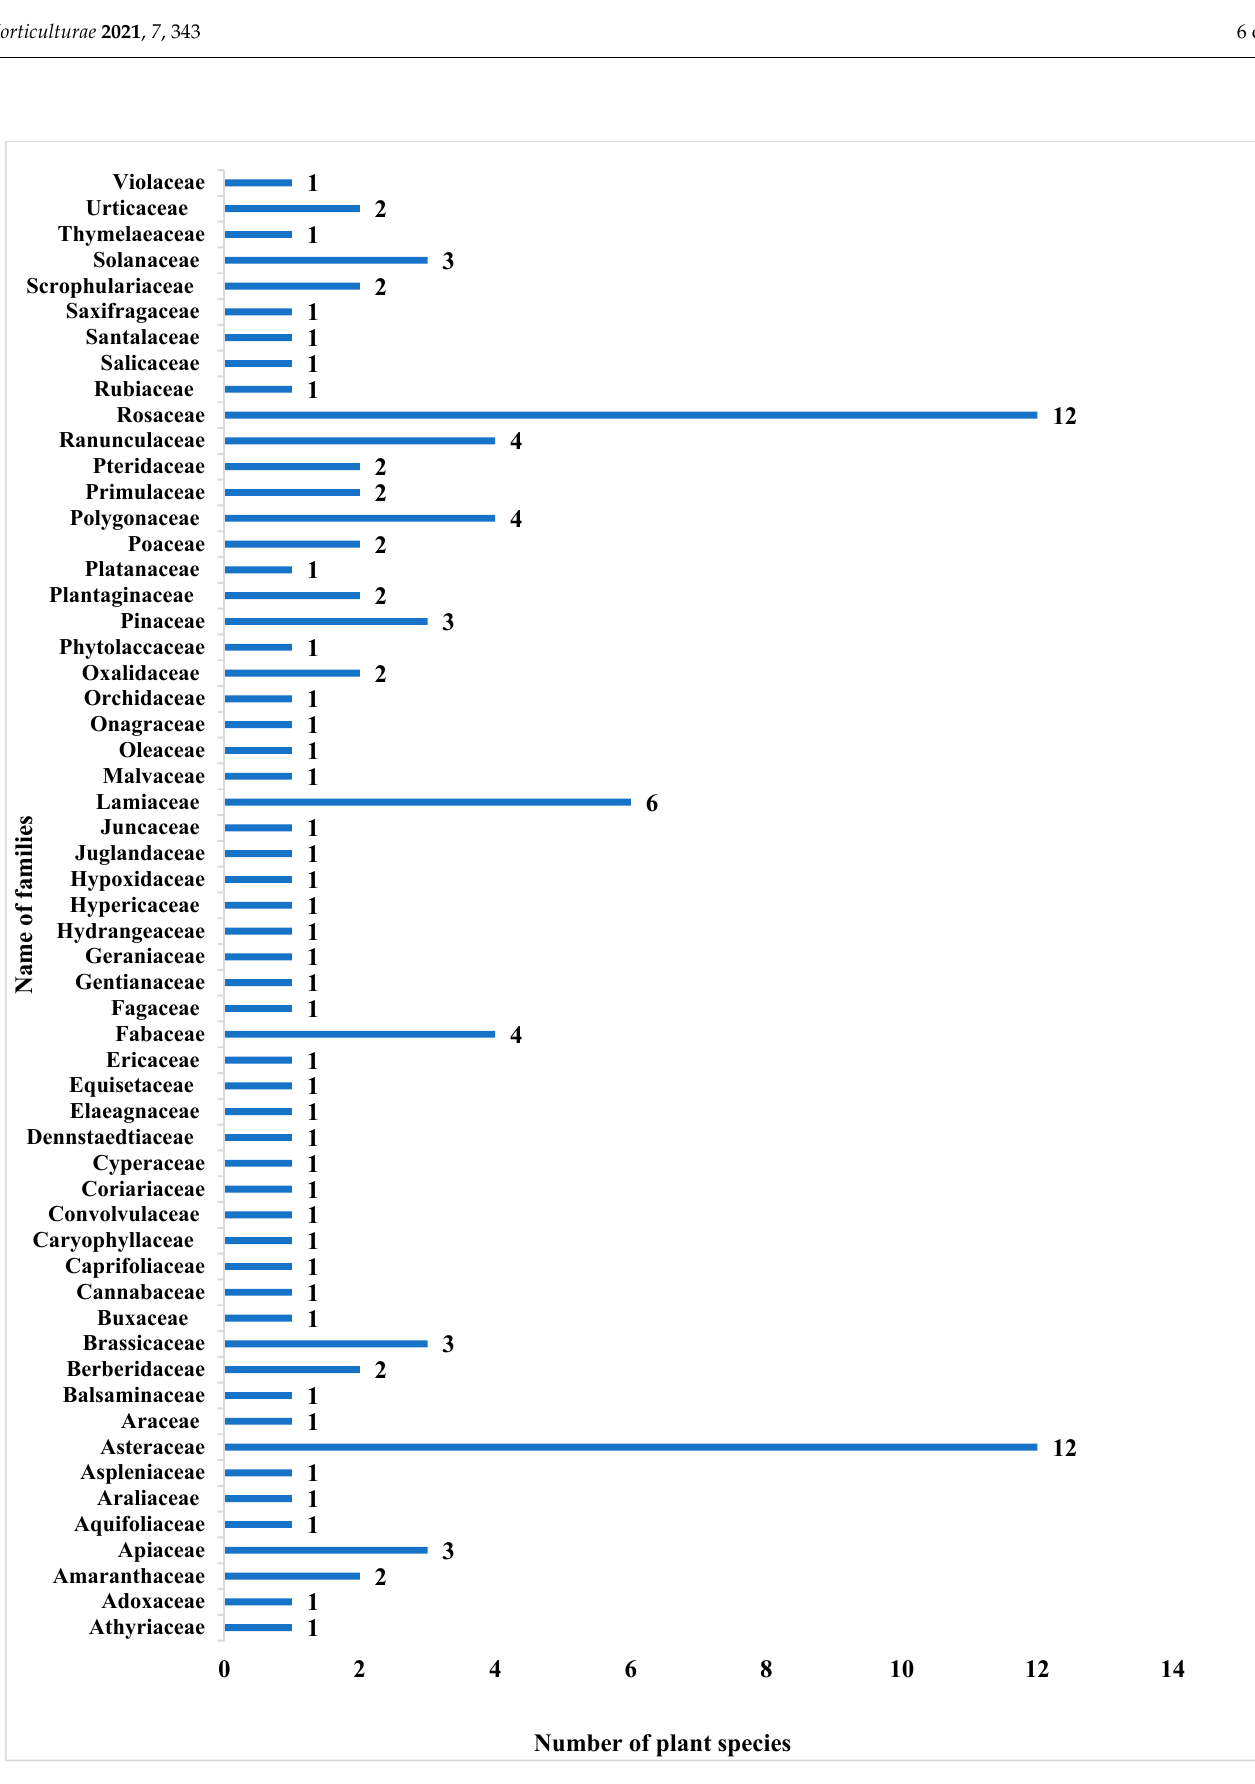
Figure 2. Representation of the number of species per family found in the study area.